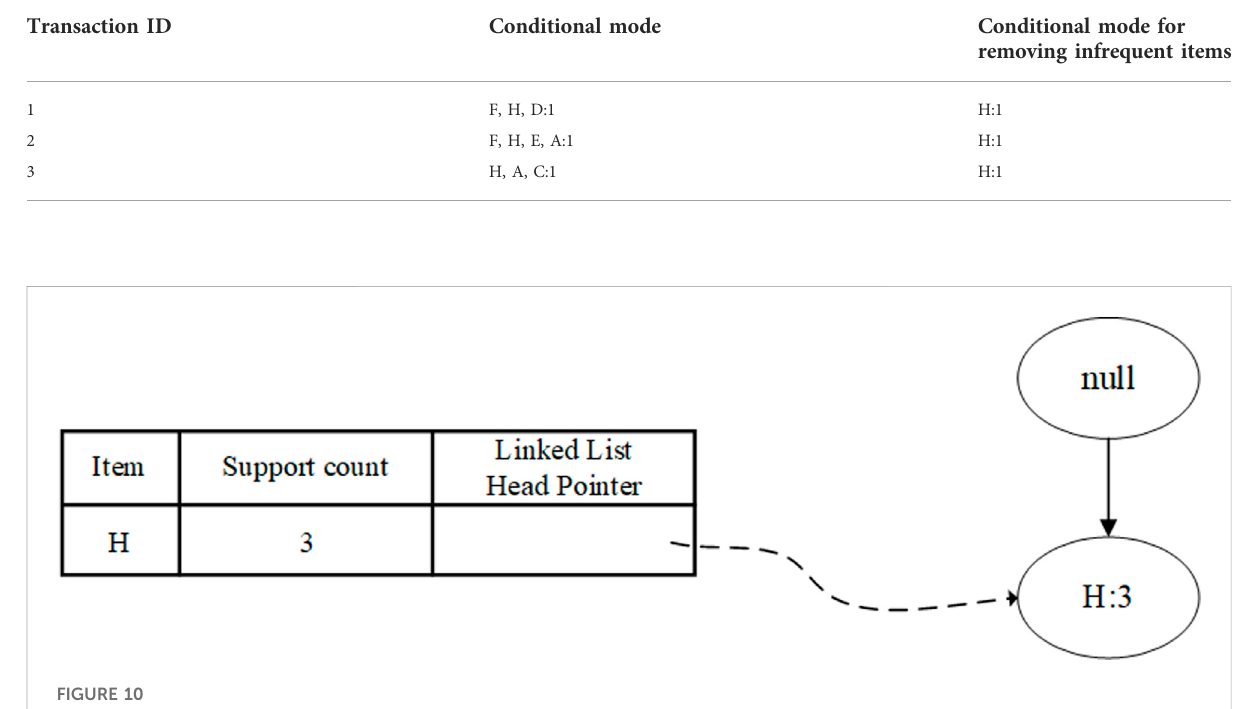
TABLE 5 Conditional pattern library.